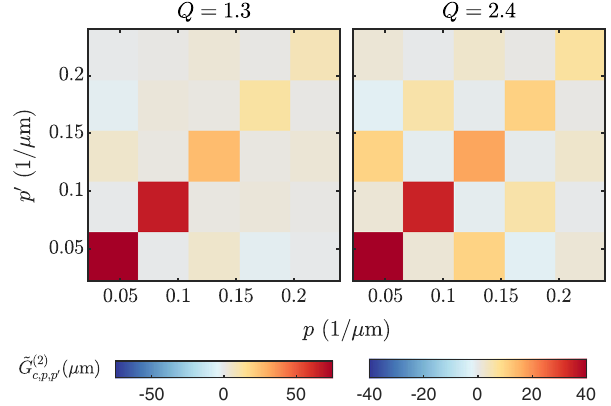
FIG. 8. Cosine transformed second-order connected correlation function. Results for different phase-locking strengths as indi- cated by the values of Q stated above the respective subplots. The color represents the values for cosine transformed second-order ˜ 2 Þ G ð connected correlation function as defined in Eq. (29). Note c;p;p 0 that the value (249.9 in the left subplot and 93.9 in the right subplot) for the lowest leftmost data point lies outside the color range. The color range is chosen to get better